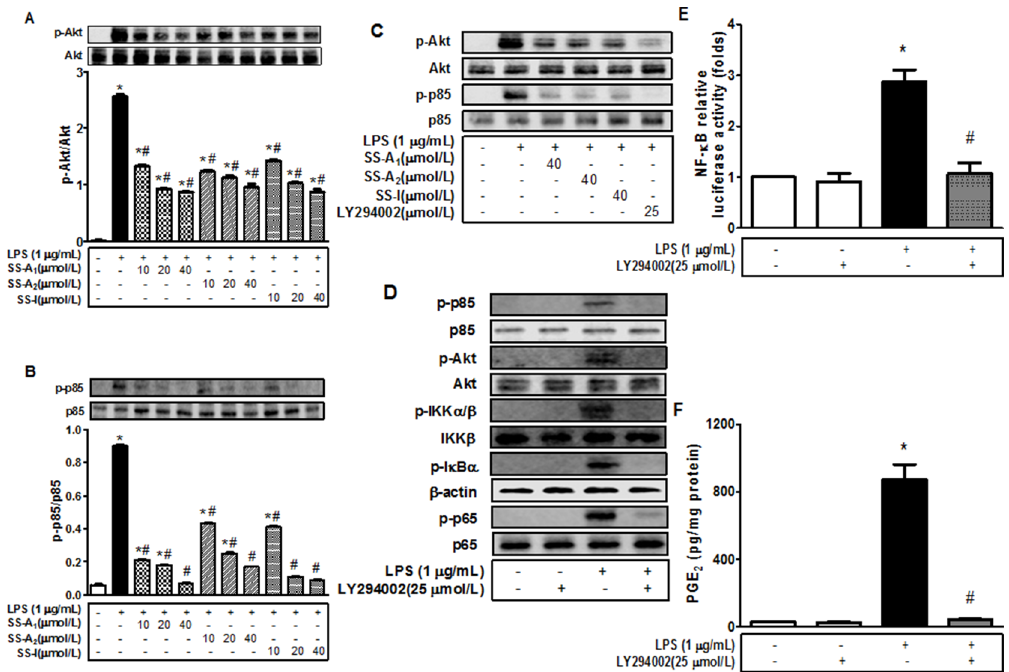
Figure 6. Soyasaponins prevent the LPS-induced PI3K/Akt activation in macrophages. Macrophages were pre-treated with 10, 20, or 40 m mol/L of soyasaponins (A 1 , A 2 and I) for 2 h, and then stimulated with LPS (1 m g/mL) for 30 min as noted. Phospho- and total Akt and p85 were detected by using immunoblotting ( A–B ). ( C ) Macrophages were pre-treated with 40 m mol/L of soyasaponins (A 1 , A 2 or I) or 25 m mol/L of LY294002 (a PI3K inhibitor) for 2 h, and then stimulated with LPS (1 m g/mL) for 30 min as noted. Phospho- and total of Akt and p85 were subsequently detected by using immunoblotting. ( D ) Macrophages were pre-treated with 25 m mol/L of LY294002 for 2 h and then stimulated with LPS (1 m g/mL) for 30 min, 15 min or 10 min as indicated. Phosph- and/or total p85, Akt, IKK a / b , IkB a and p65 were detected by using immunoblotting. ( E ) The pNF- kB-Luc plasmids were introduced into macrophages using transient transfection for overnight, and then stimulated with 1 m g/mL of LPS in the absence or presence of LY294002 (25 m mol/L) for 16 h as noted. The level of luciferase activity was evaluated and presented as fold of the negative control. ( F ) Macrophages were pre-treated with 25 m mol/L of LY294002 for 2 h, and then stimulated with 1 m g/mL of LPS for 16 h, followed by measurement of